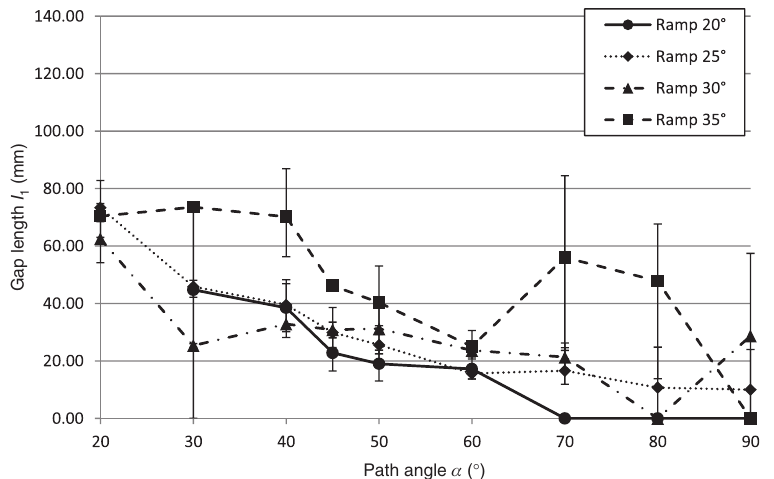
at the bottom of the ramp. 3